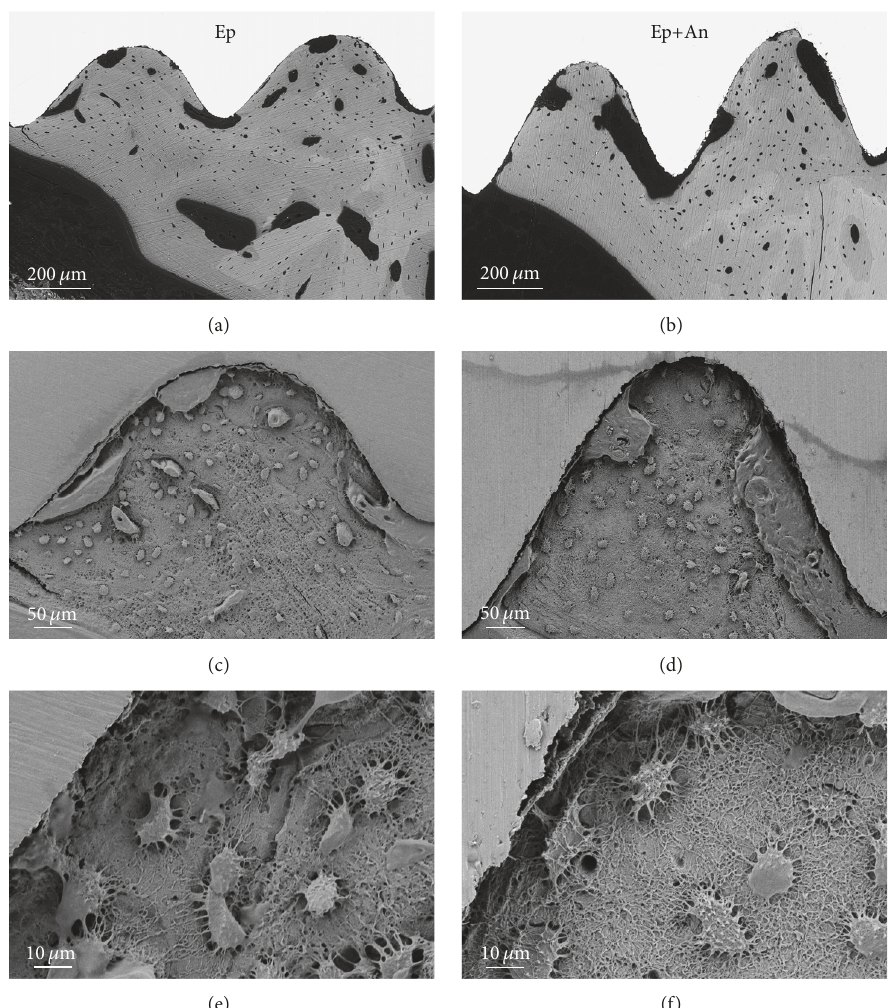
Figure 3: Backscattered electron scanning electron microscopy. High amounts of well-mineralised bone are observed within and outside the (a) Ep and (b) Ep+An implant threads. (c–f) Resin cast etching and direct visualisation of osteocytes forming a vast network of the lacunocanalicular system in close proximity to the (c, e) Ep and (d, f) Ep+An implant